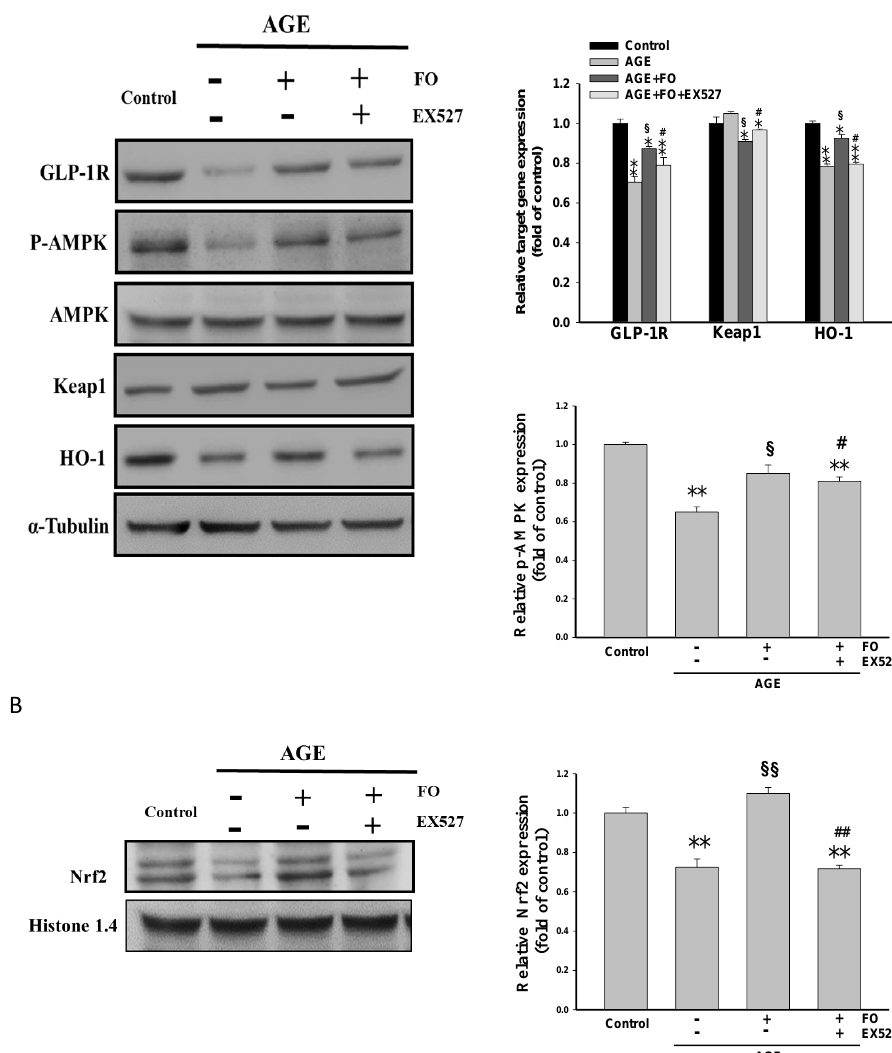
Figure 2. The e ff ects of fucoidan on Nrf2 activation and the expression of glucagon-like peptide-1 receptor (GLP-1R), AMP-activated protein kinase (AMPK), and heme oxygenase-1(HO-1). The NRK-52E cells were incubated with AGE (100 µ g / mL) for 24 h followed by treatment with fucoidan (100 µ g / mL) for 24 h in the presence or absence of EX527 (200 nM). The expression of glucagon-like peptide-1 receptor (GLP-1R), AMP-activated protein kinase (AMPK), p -AMPK, Kelch-like ECH-associated protein 1 (Keap1), and HO-1 ( A ), and the nuclear level of Nrf2 ( B ) was determined in various groups. Results were expressed as the mean ± S.E.M ( n = 5). * p < 0.05, ** p < 0.01 vs. control group; § p < 0.05, §§ p < 0.01 vs. AGE-treated alone cells; # p < 0.05, ## p < 0.01 vs. AGE and fucoidan-treated